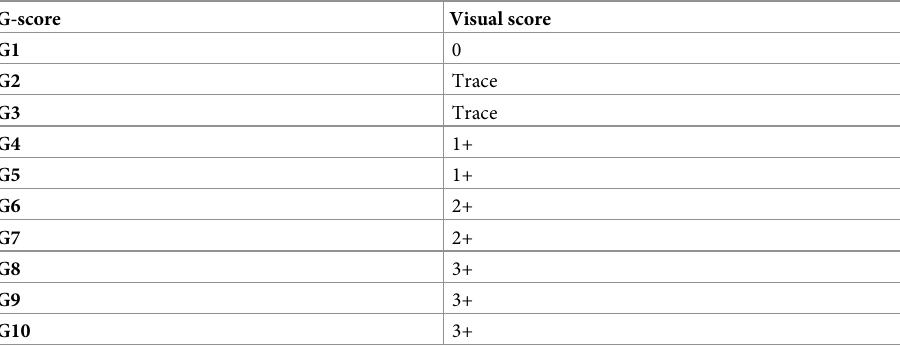
Table 1. G scores and their corresponding visual score